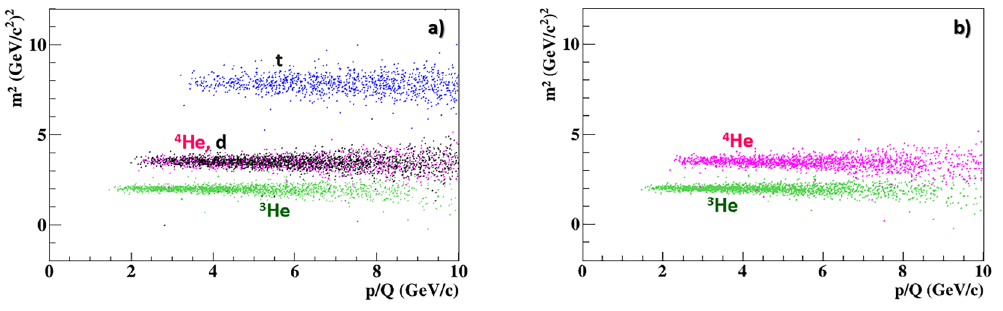
Figure 5. [Color online] The squared mass of charged particles from the signal events as a function of the particle momentum: a) in case when only information from TOF is considered (without STS), and b) TOF after ∆ E / ∆ x and ω k criterion cuts in n